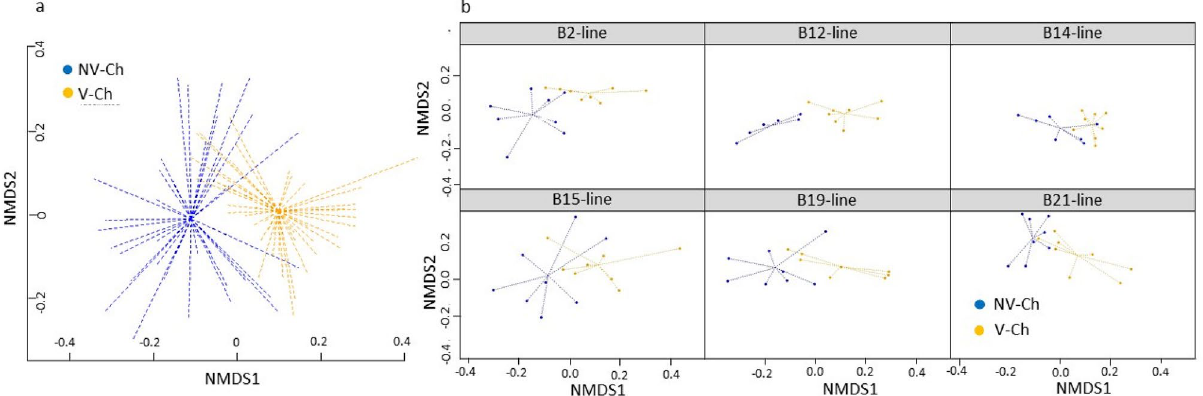
Figure 3. Effect of IBV vaccination on the caecal microbial community of 9-weeks-old hens infected with IBV. ( a ) NMDS representation of the caecal microbial communities using Bray–Curtis distances among the vaccinated challenged (V-Ch, n = 48) (orange) and the non-vaccinated challenged (NV-Ch, n = 45) (blue) groups considering all the lines together. ( b ) NMDS representation of the caecal microbial communities in each MHC line separately. Arrows represent the centroids displacement from the non-vaccinated challenged (NV-Ch) group (blue) to the vaccinated challenged (V-Ch) group